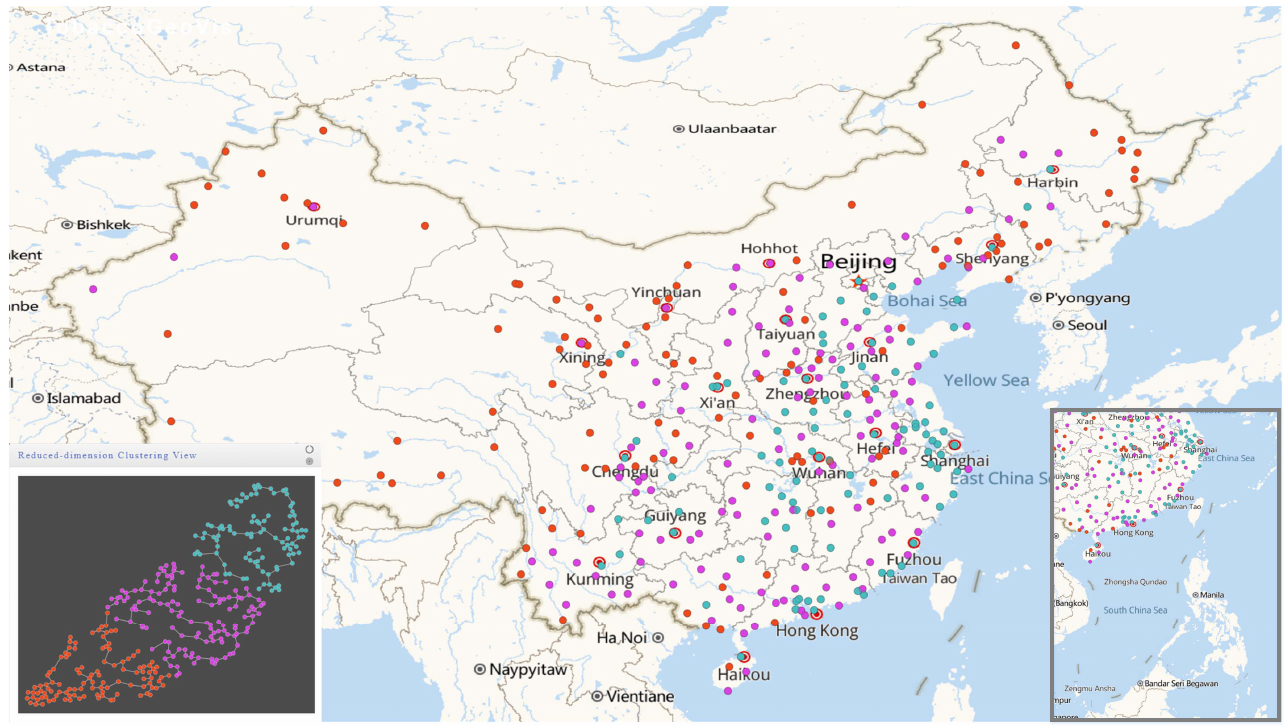
Figure 9. Similarity visualization of the cigarette delivery